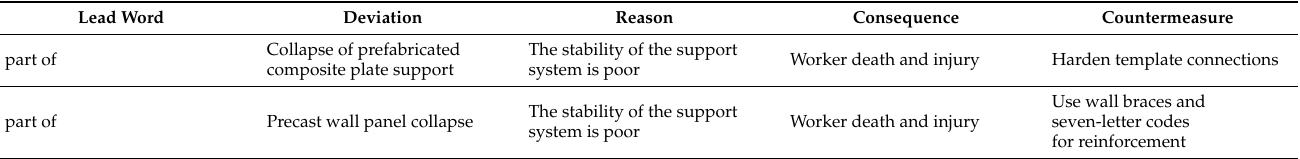
Table 12. HAZOP analysis of the component correction